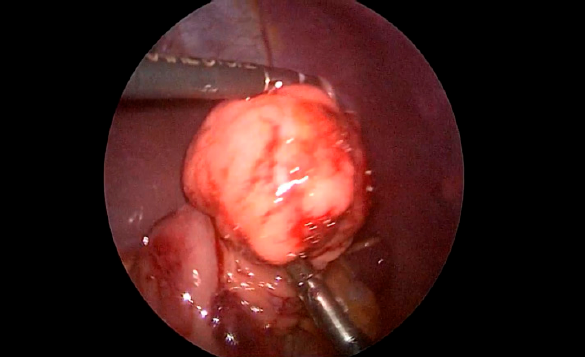
Figure 4. Laparoscopic excision of the duodenal polyp (The straightened duodeno-jejunal junction allowed for the visualization and resection of the duodenal polyp during repeated mucosal mobili- zation).